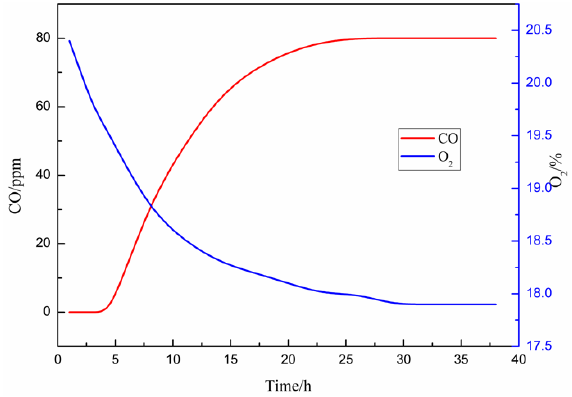
Figure 3. Curves of the second time of ambient temperature oxidation experiment results.